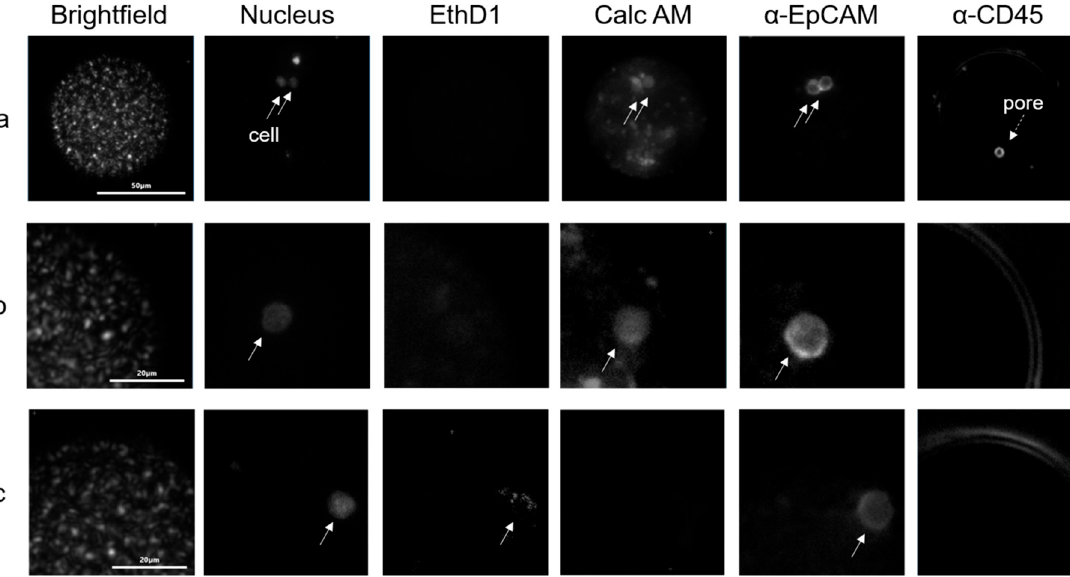
Figure 6. Images of CTCs in three microwells (Panels a, b & c) after isolation from 7.5 mL blood of a metastatic prostate cancer patient. The first image in the panels shows a bright field image showing the contours of the microwell, the objects in the image are residual red blood cells that end up in the well after blockage of the pore. Panel A shows the images of a CTC cluster consisting of two viable CTC (Nucleus+, EthD1-, Cals AM+, α -EpCAM+, α -CD45-). Panel B shows an example of a single viable CTC (Nucleus+, EthD1-, Cals AM+, α -EpCAM+, α -CD45-) and panel C shows a dead CTC (Nucleus+, EthD1+, Cals AM-, α -EpCAM+, α -CD45-). The solid arrows point to the position of the cells and the dashed arrow in the right image of panel A shows the position of the pore in the microwell visible through the PerCP filter